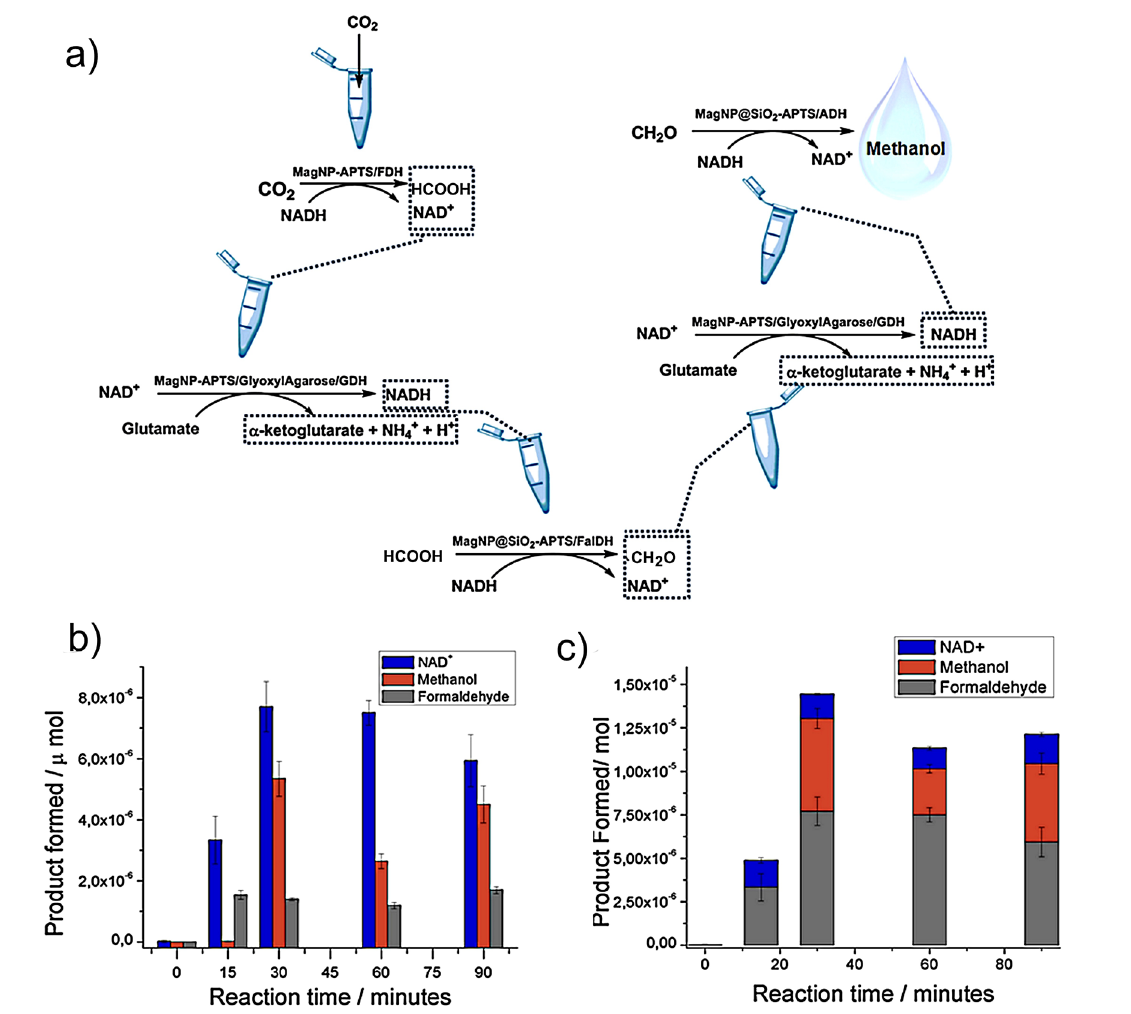
-methanol sequential reaction; ( b ) cascade multienzymatic CO Figure 5 - ( a ) CO 2 formaldehyde, methanol and NAD + formed with reaction progress; ( c ) cascade multienzymatic CO